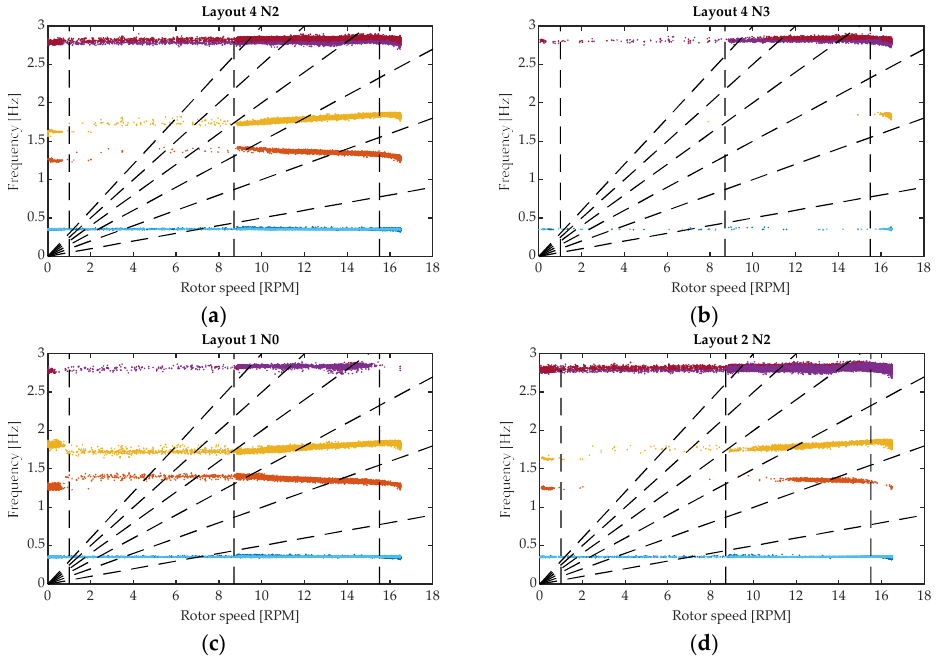
Figure 6. Campbell diagram with the tracked vibration modes with: ( a ) Layout 4 N2; ( b ) Layout 4 N3; ( c ) Layout 1 N0; ( d ) Layout 2 N2.